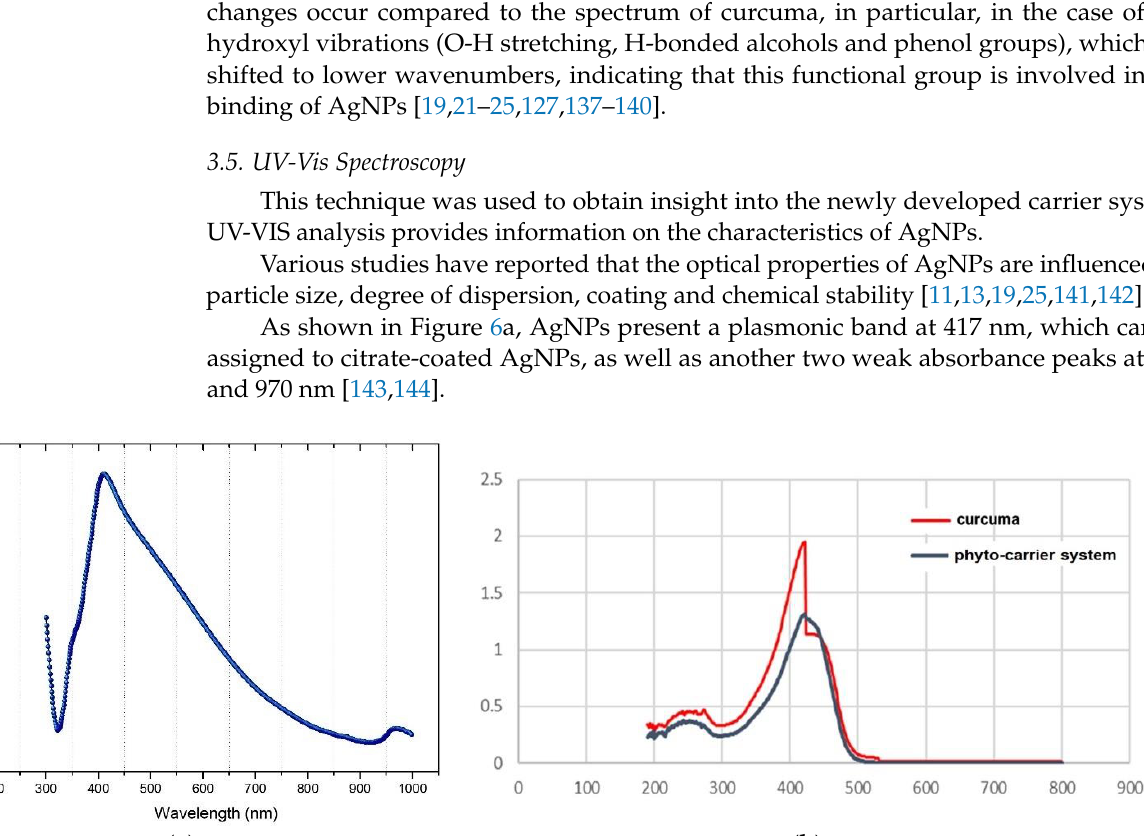
( b ) Figure 7. ( a ) Powder XRD patterns of AgNPs; ( b ) XRD patterns of curcuma and the phytocarrier system.